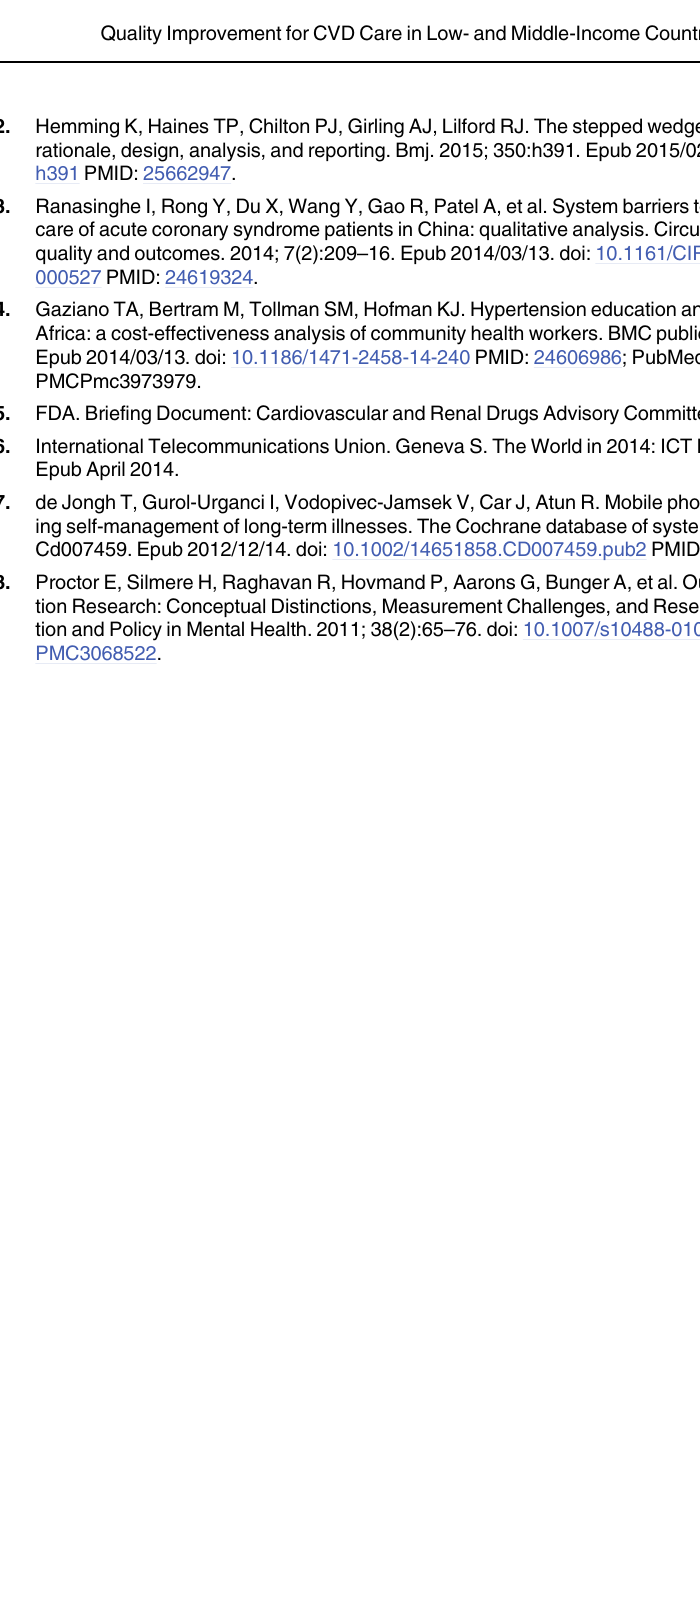
PLOS ONE | DOI:10.1371/journal.pone.0157036 June 14,